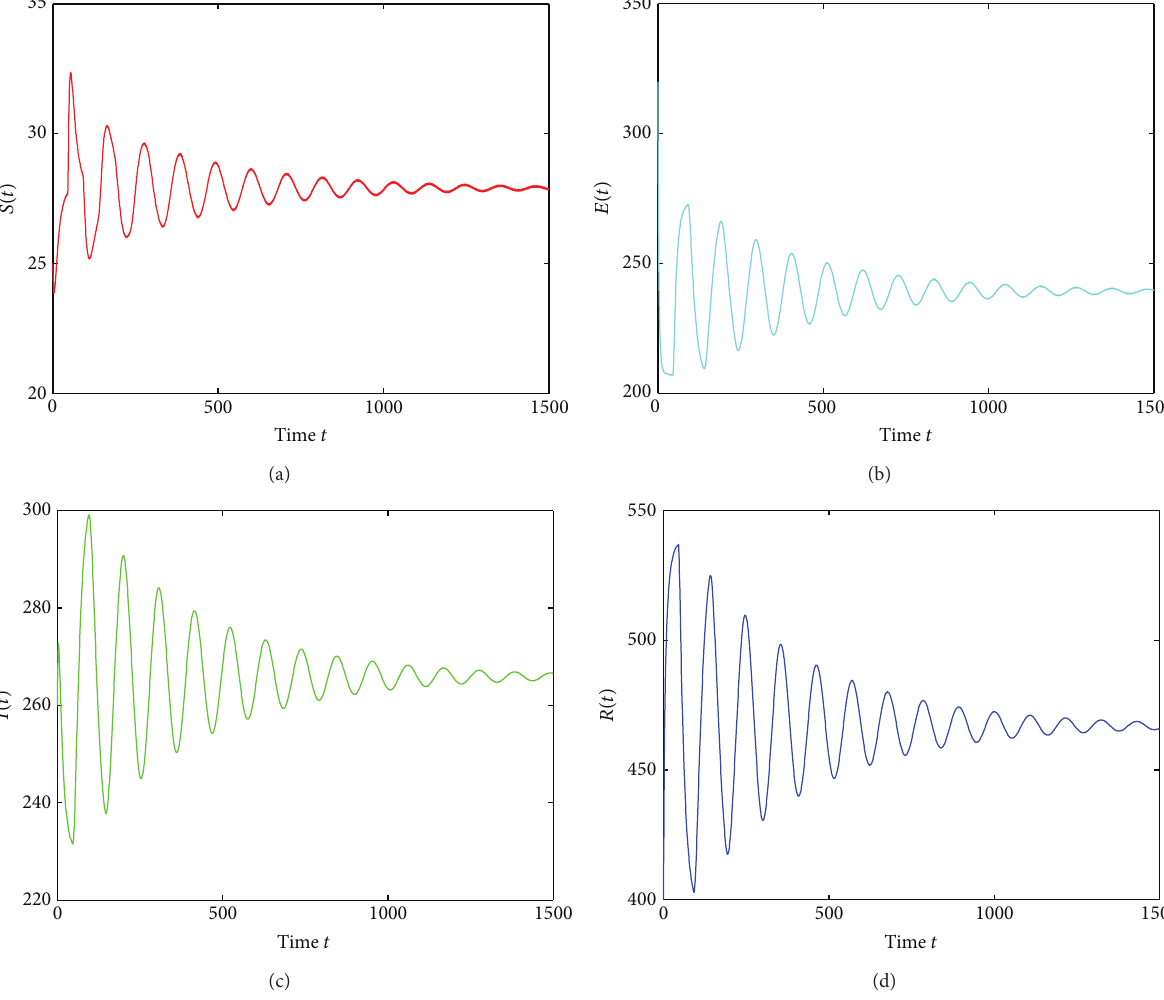
Figure 5: The track of the states 𝑆 , 𝐸 , 𝐼 , and 𝑅 for 𝜏 2 = 45.5000 < 52.4927 = 𝜏 20